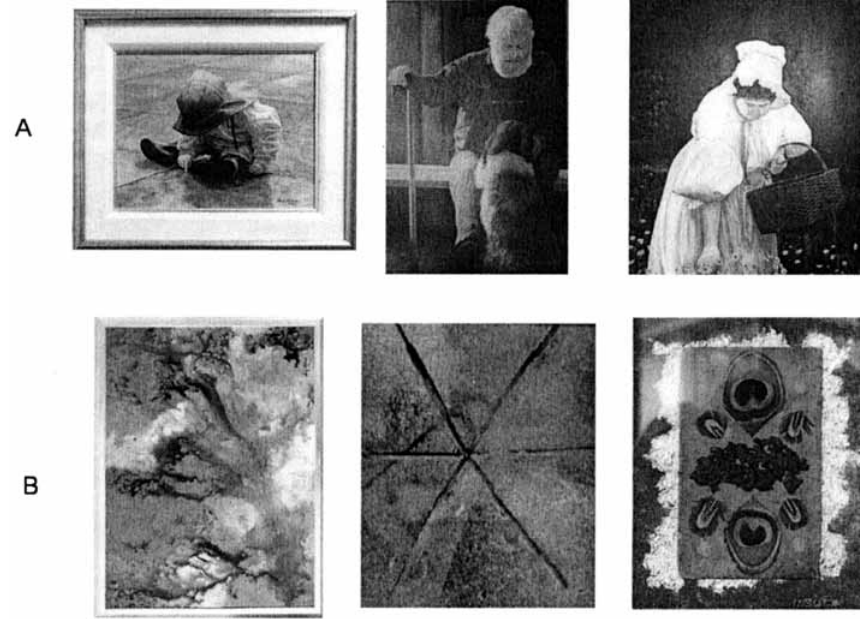
Fig. 4. Example of Visual Perceptual Changes in PCA. The paintings of a 58 year-old artist who developed PCA. Panel A. Near photographic renditions of the subject matter before onset of PCA; Panel B. Equally artistic but abstract paintings after onset of